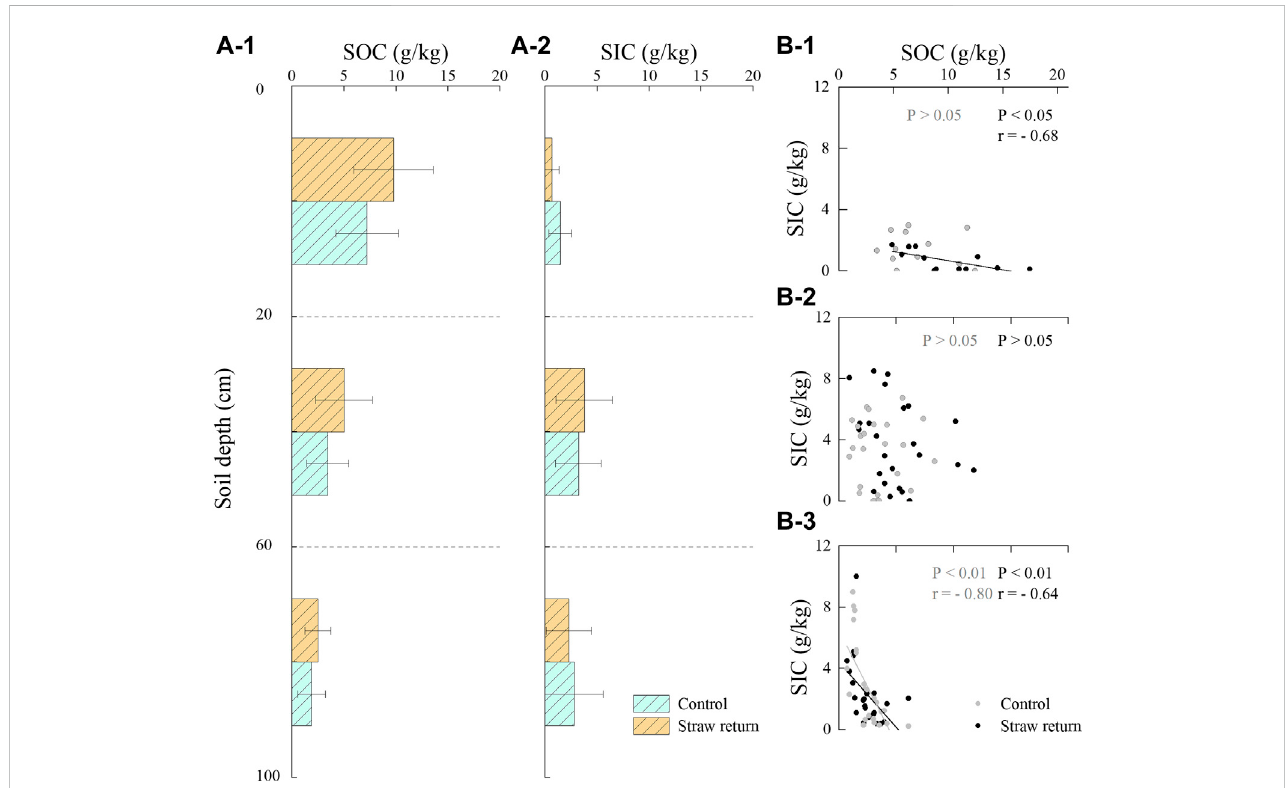
FIGURE 1 Vertical distribution of SOC (a-1) and SIC contents (a-2) ; Relationships between SOC and SIC contents in the surface (b-1) , subsoil (b-2) , and under- subsoil (b-3) layers. Bars indicate mean ± SD values ( n = 3); * denotes p <